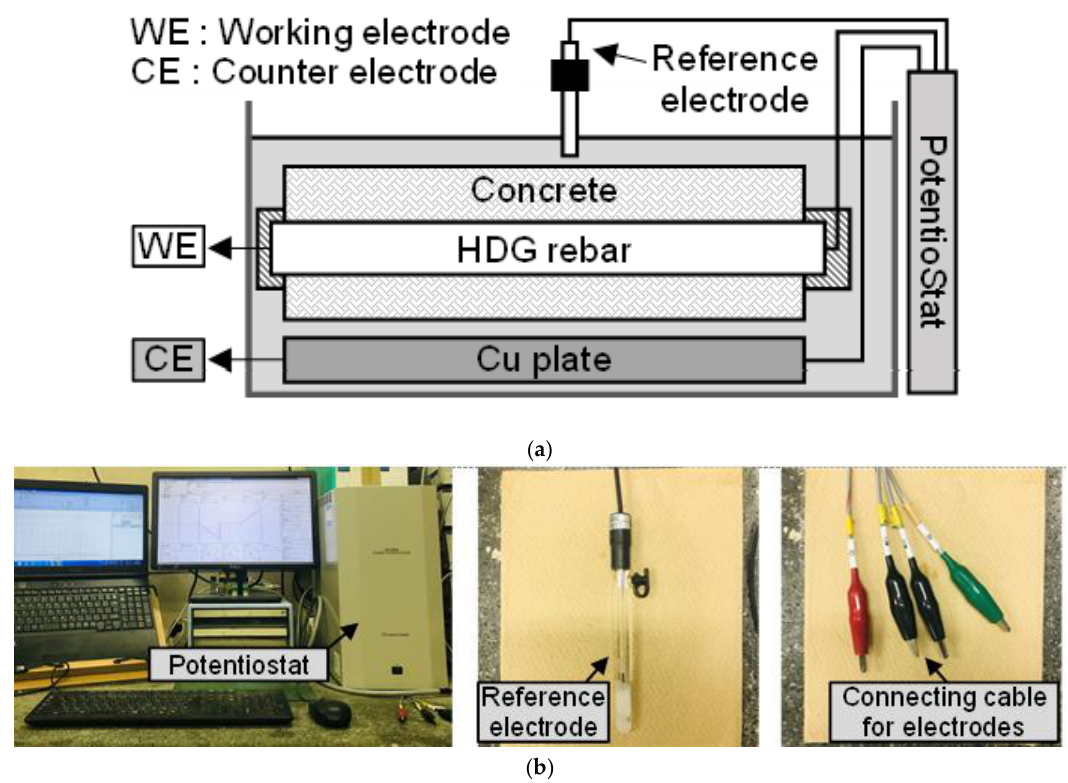
Figure 4. ( a ) Polarization test; ( b ) View of the polarization test outline and the main measurement devices.